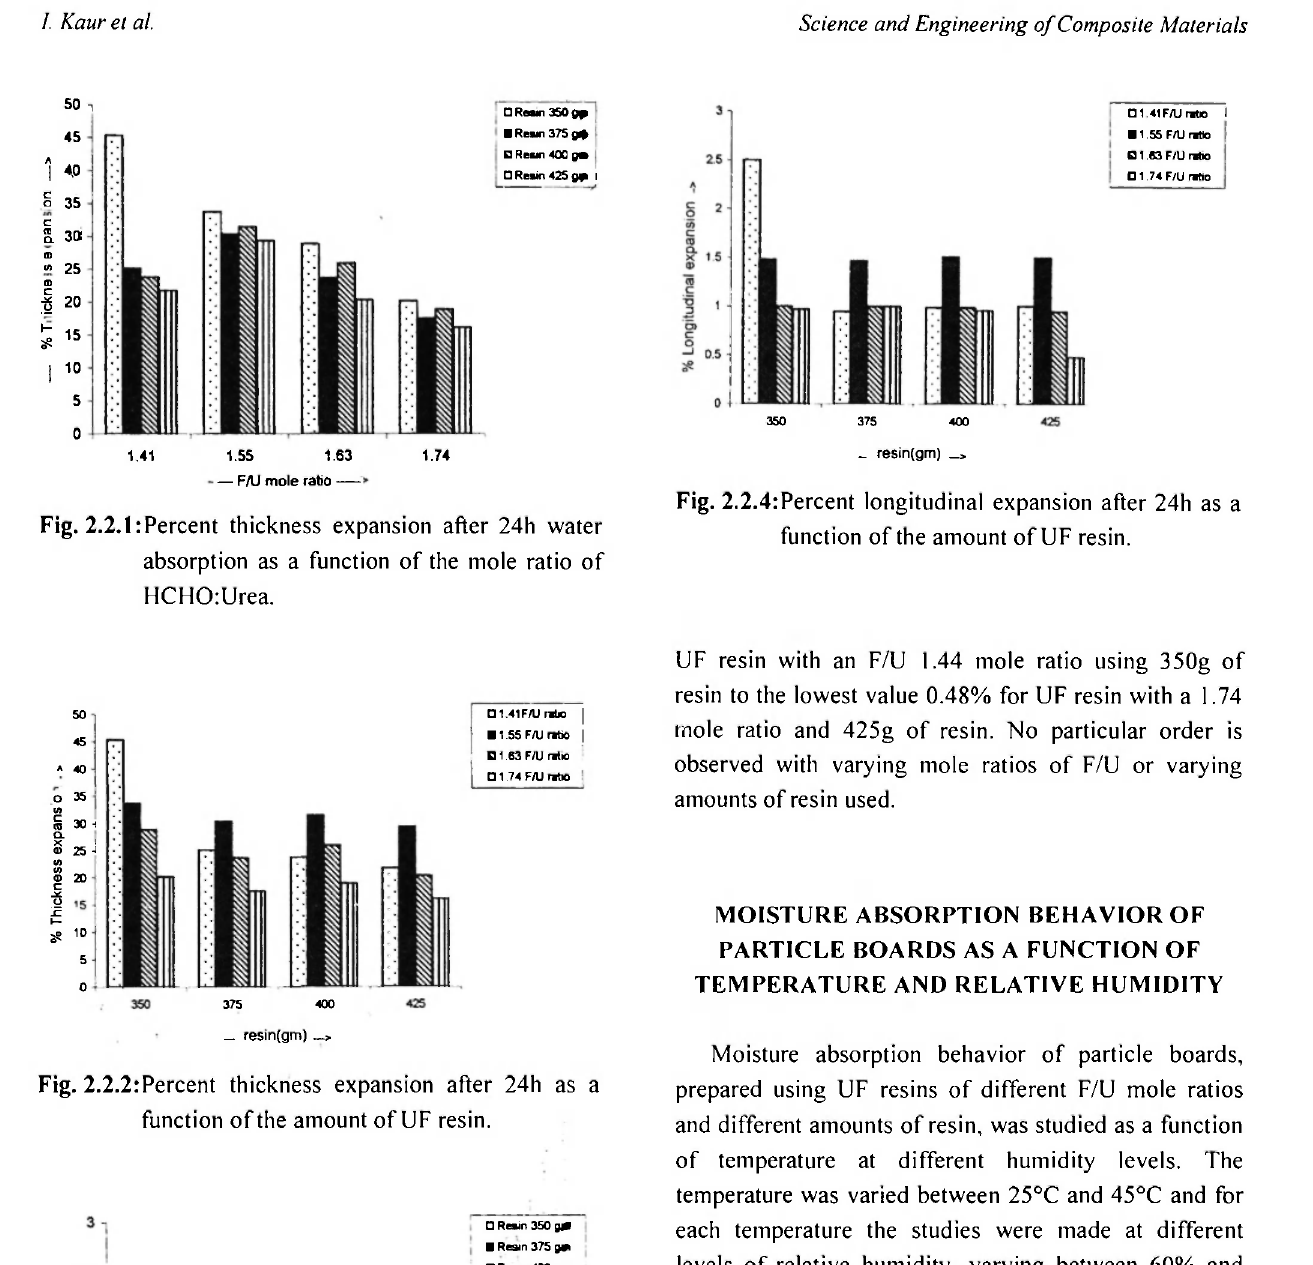
Fig. 2.2.2: Percent thickness expansion after 24h as a function of the amount of UF resin.